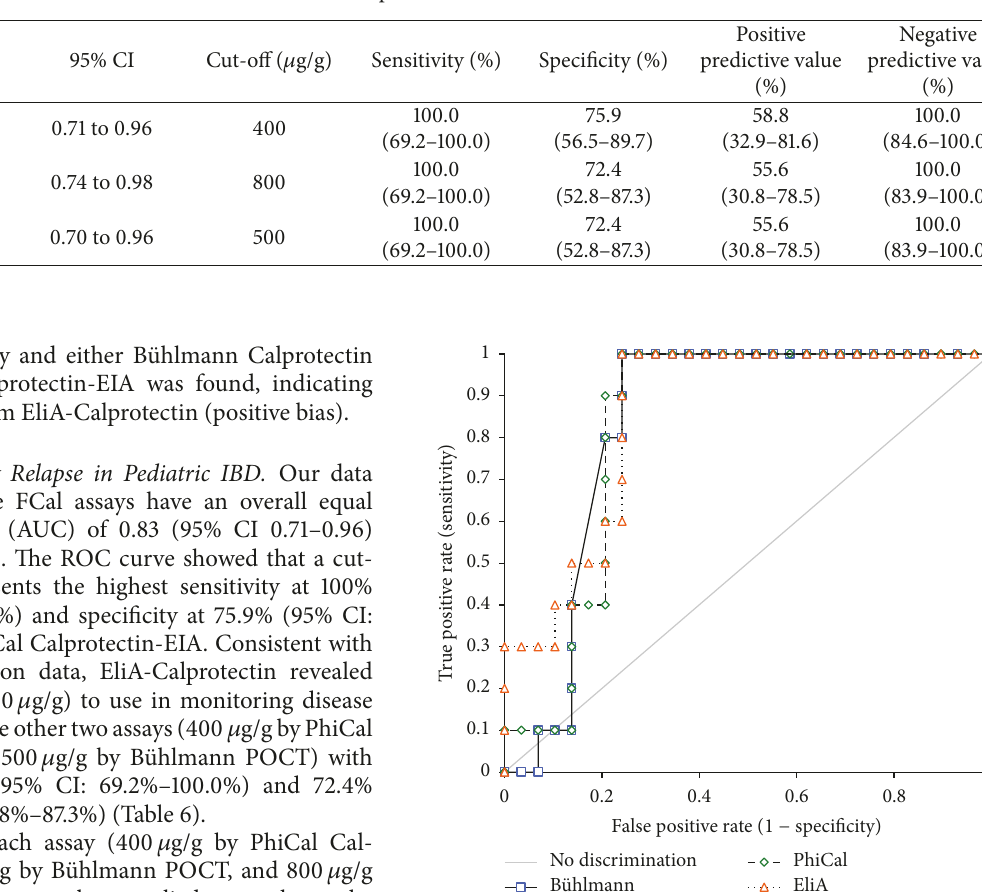
Table 6: Clinical performance of FCal.